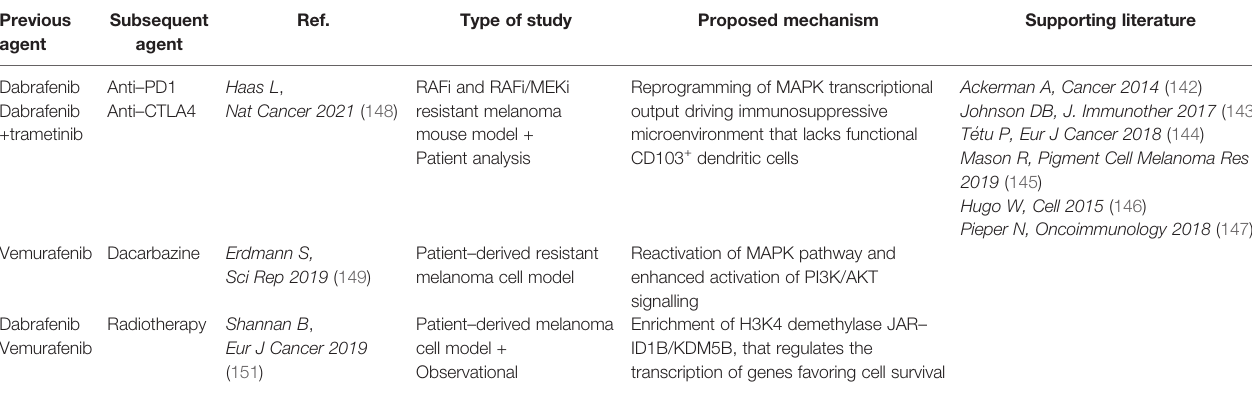
TABLE 5 | Cross – resistance in MAPK – targeted therapies. Previous Subsequent agent agent